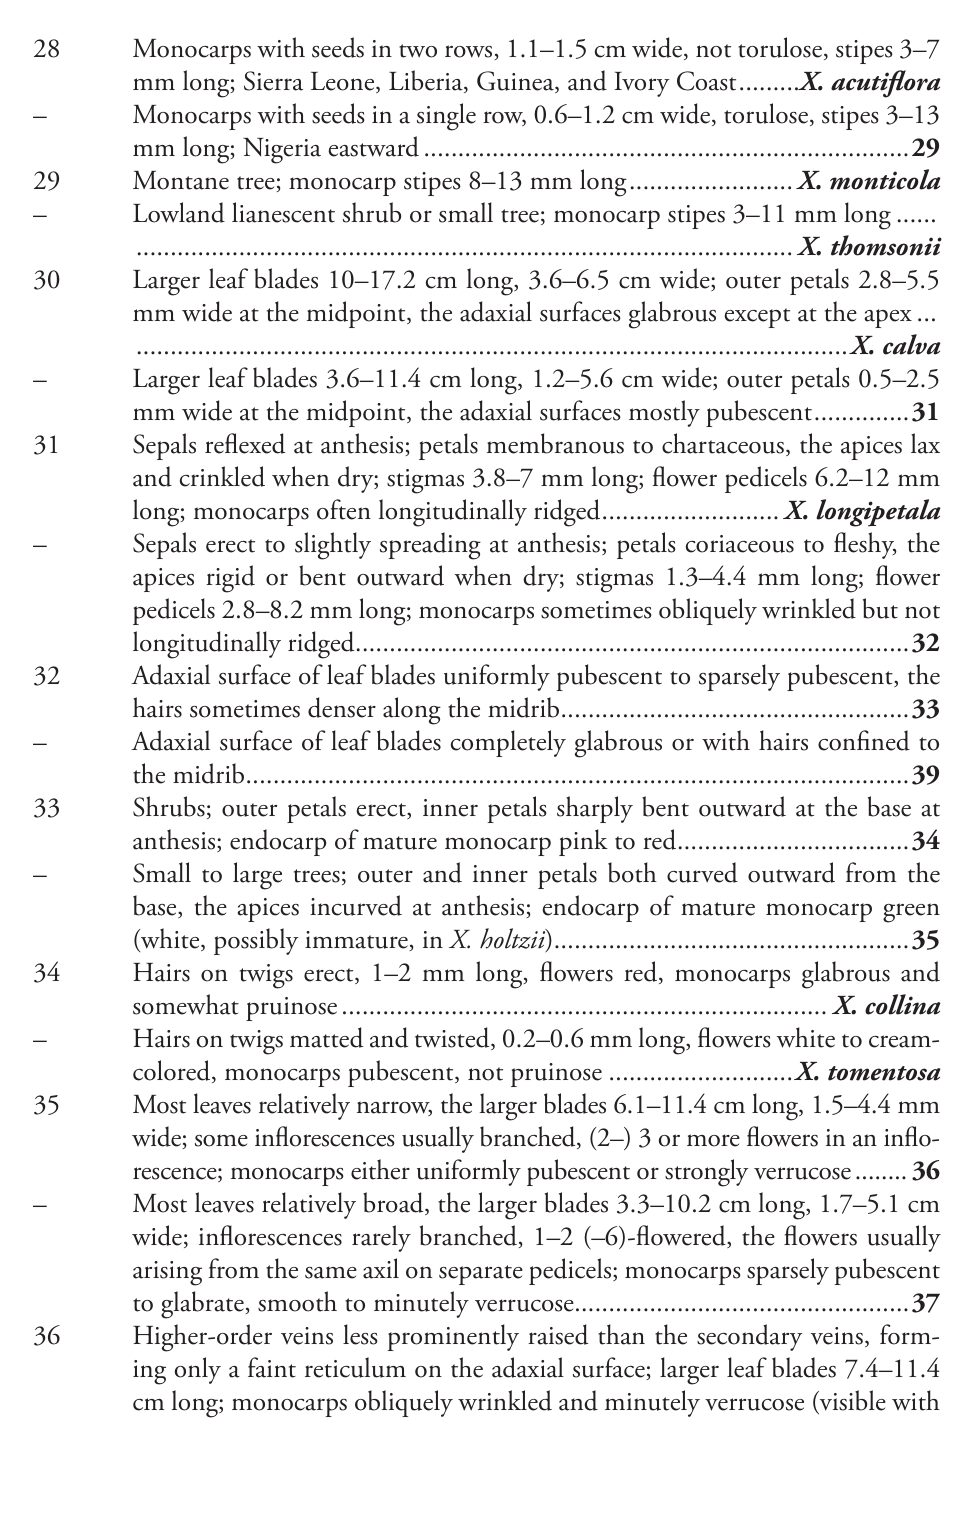
Higher-order veins less prominently raised than the secondary veins, form- ing only a faint reticulum on the adaxial surface; larger leaf blades 7.4–11.4 cm long; monocarps obliquely wrinkled and minutely verrucose (visible